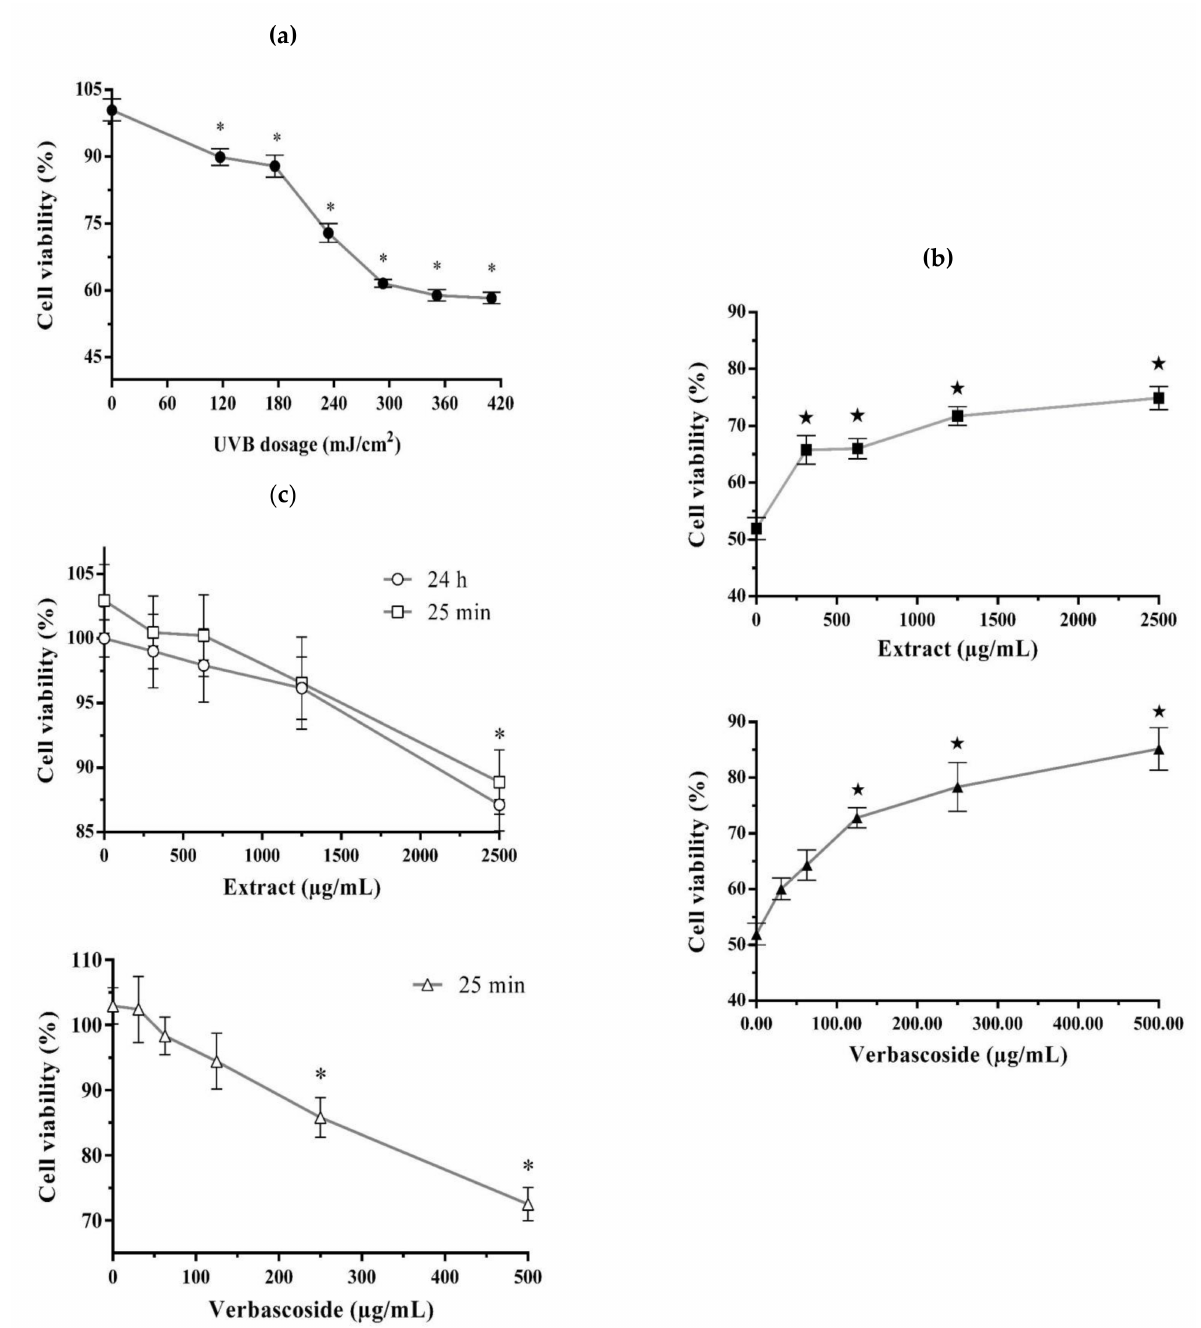
Figure 1. Photoprotective and cytotoxic effects of B. cordata cell culture methanolic extract on 3T3-Swiss albino